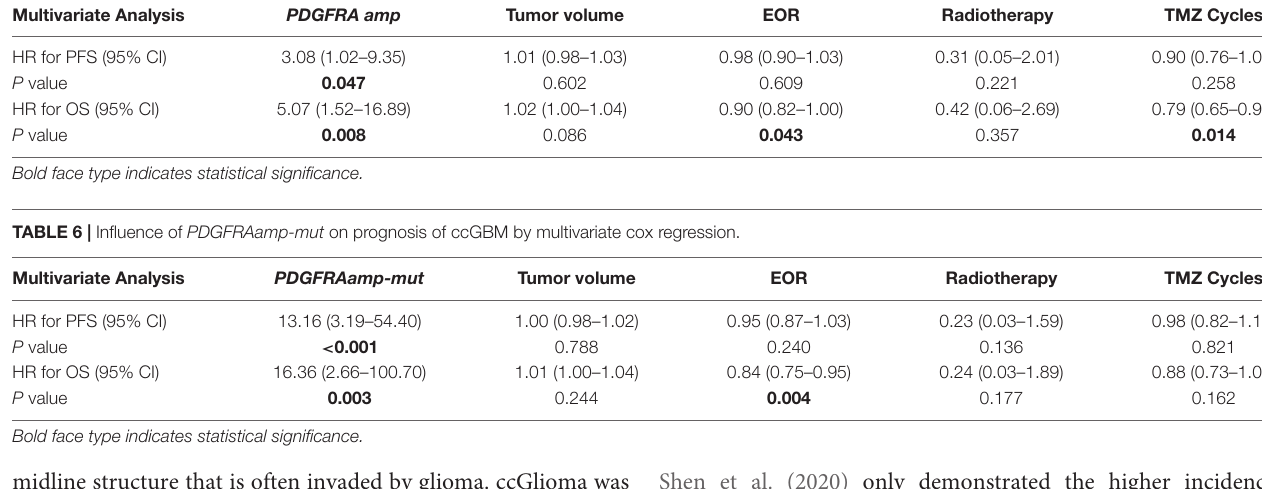
FIGURE 3 | Kaplan-Meier survival curves of different groups. The ccGBM of PDGFRAamp vs. non-ccGBM of PDGFRAnon-amp (A,B) , ccGBM of PDGFRAamp-mut vs. non-ccGBM of PDGFRA-w, non-amp (C,D) , ccGBM of PDGFRA-w, non-amp compared to ccGBM of PDGFRAamp and PDGFRAamp-mut (E,F) , and ccGBM vs. DMG (G,H) . TABLE 5 | Influence of PDGFRAamp on prognosis of ccGBM by multivariate cox regression. Multivariate Analysis